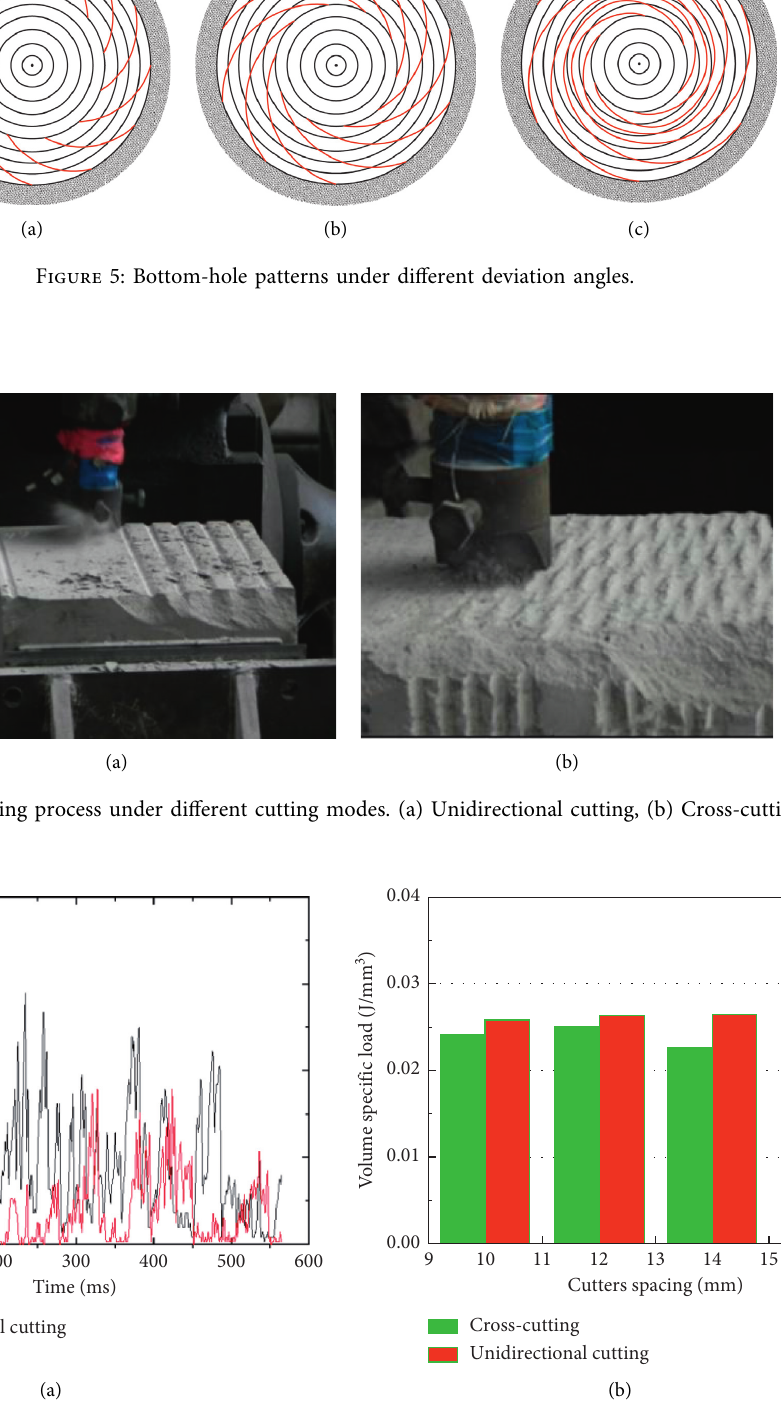
Figure 7: Change regulation of cutting force and volume-specific load under different cutting modes. (a) Cutting force and (b) volume- specific